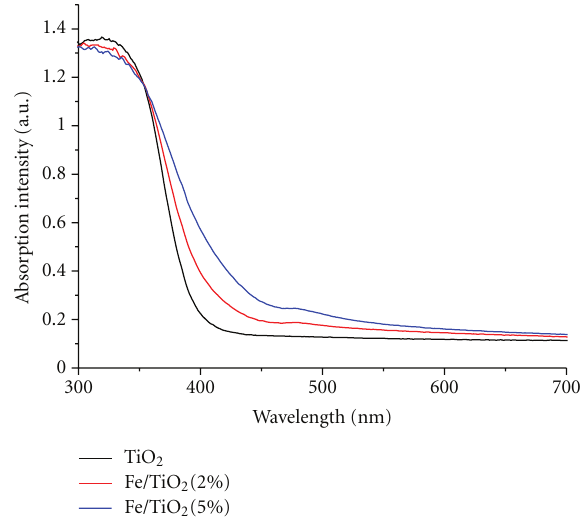
Figure 5: The UV-Vis absorption spectra of TiO 2 with di ff erent amounts of Fe